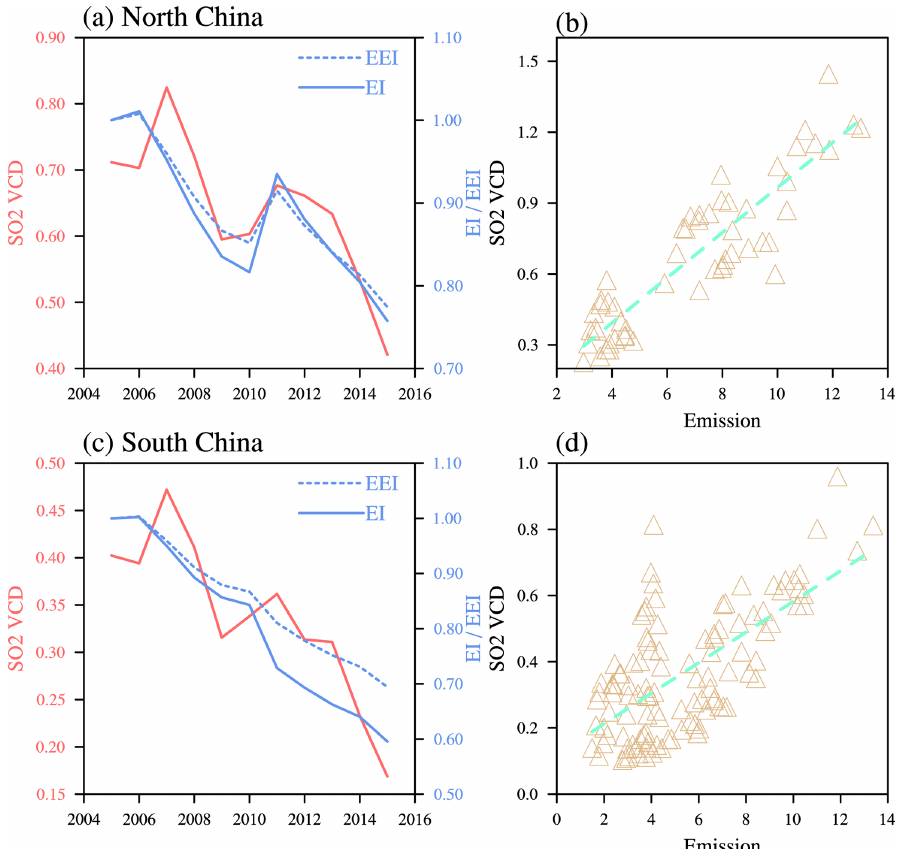
Figure 10. Time series plots of SO 2 VCD and EI/EEI (a, c) , and scatter plots with the regression line of SO 2 VCD and emission (b, d) for North China (a, b) and South China (c, d) . Each marker in (b) and (d) corresponds to one year and one province.